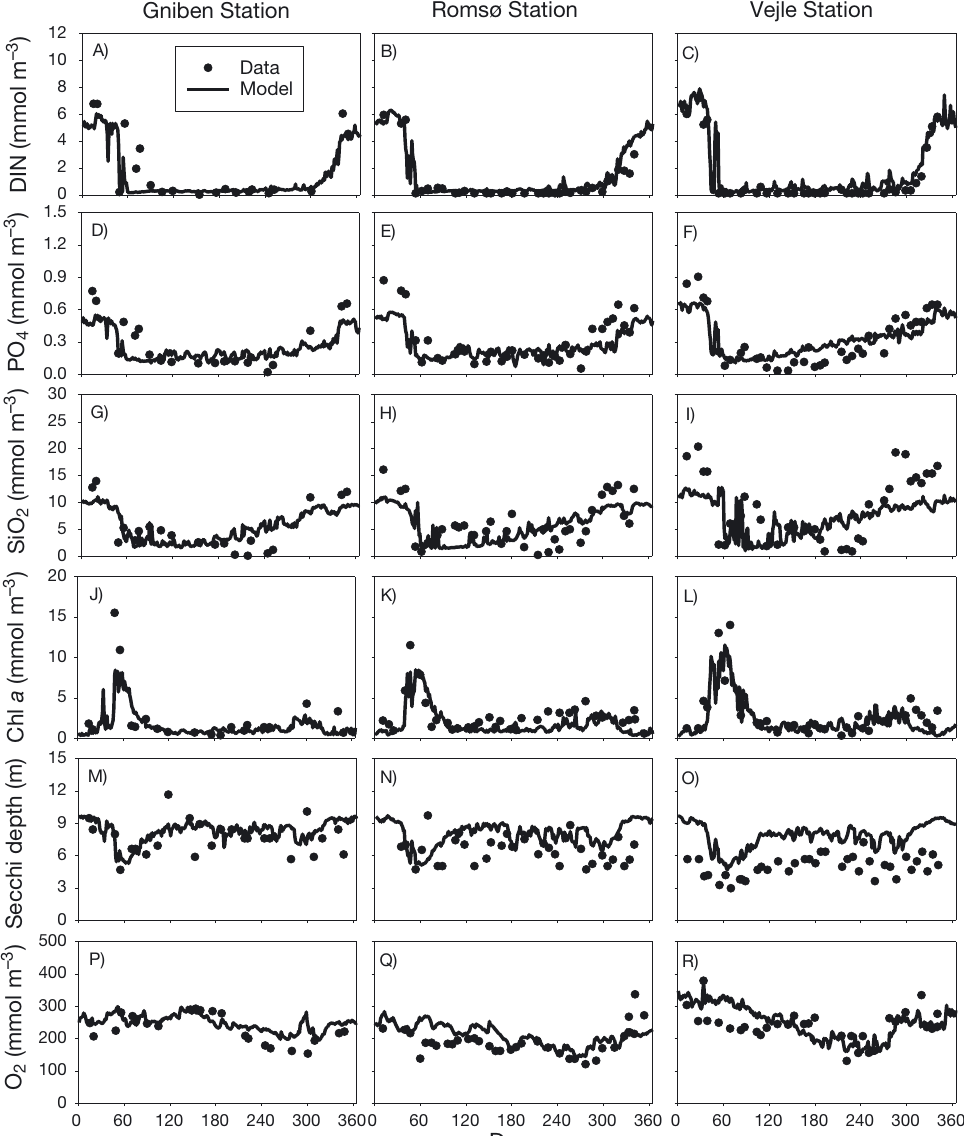
Fig. 5. Model validation of surface (1 m) (A−C) dissolved inorganic nitrogen (DIN), PO 4 , SiO 2 , (J−L) chl a , (M−O) Secchi depth and (P−R) bottom oxygen at the 3 monitoring stations in